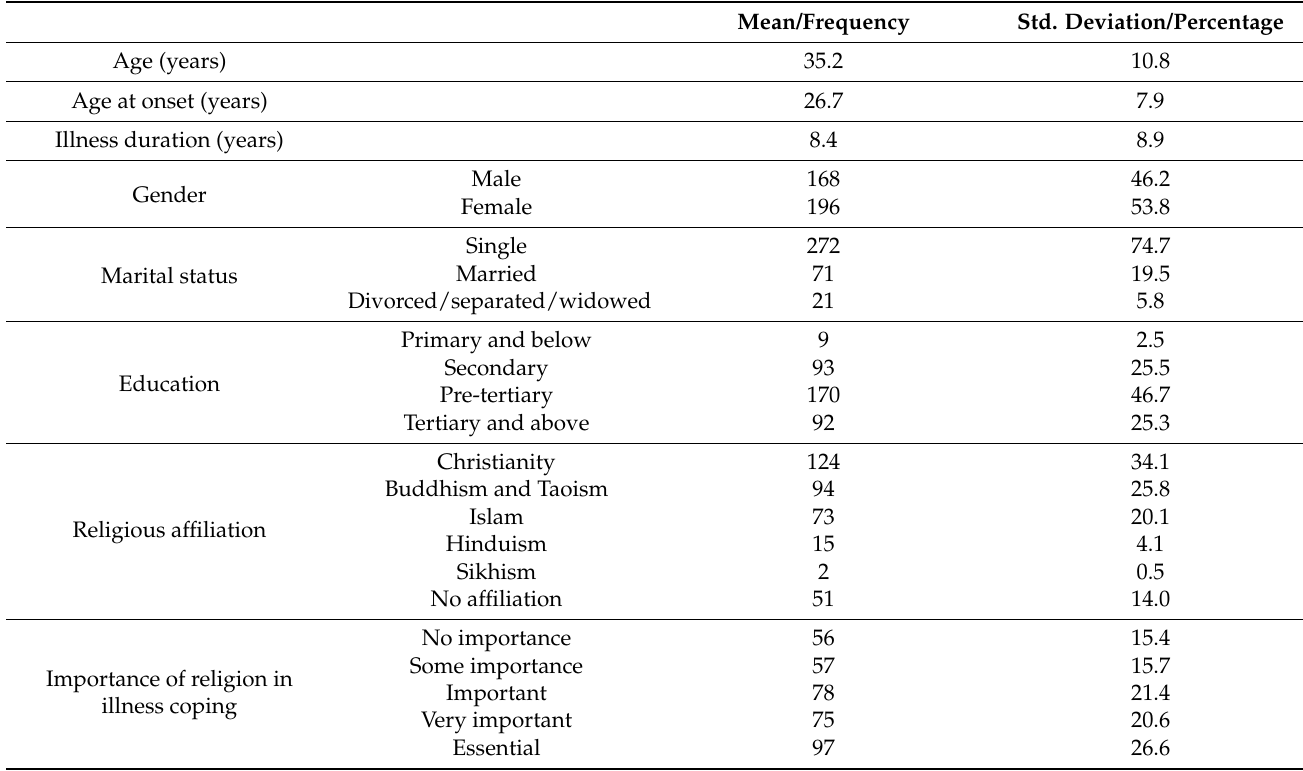
Table 1. Sociodemographic and clinical variables ( n =